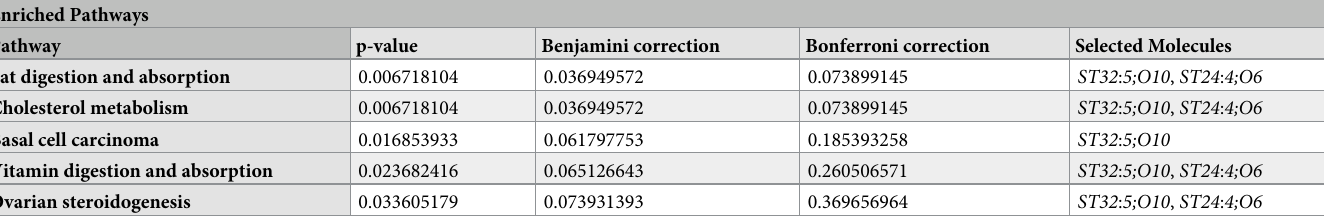
Table 6. Enrichment analysis of lipids associated with COVID-19